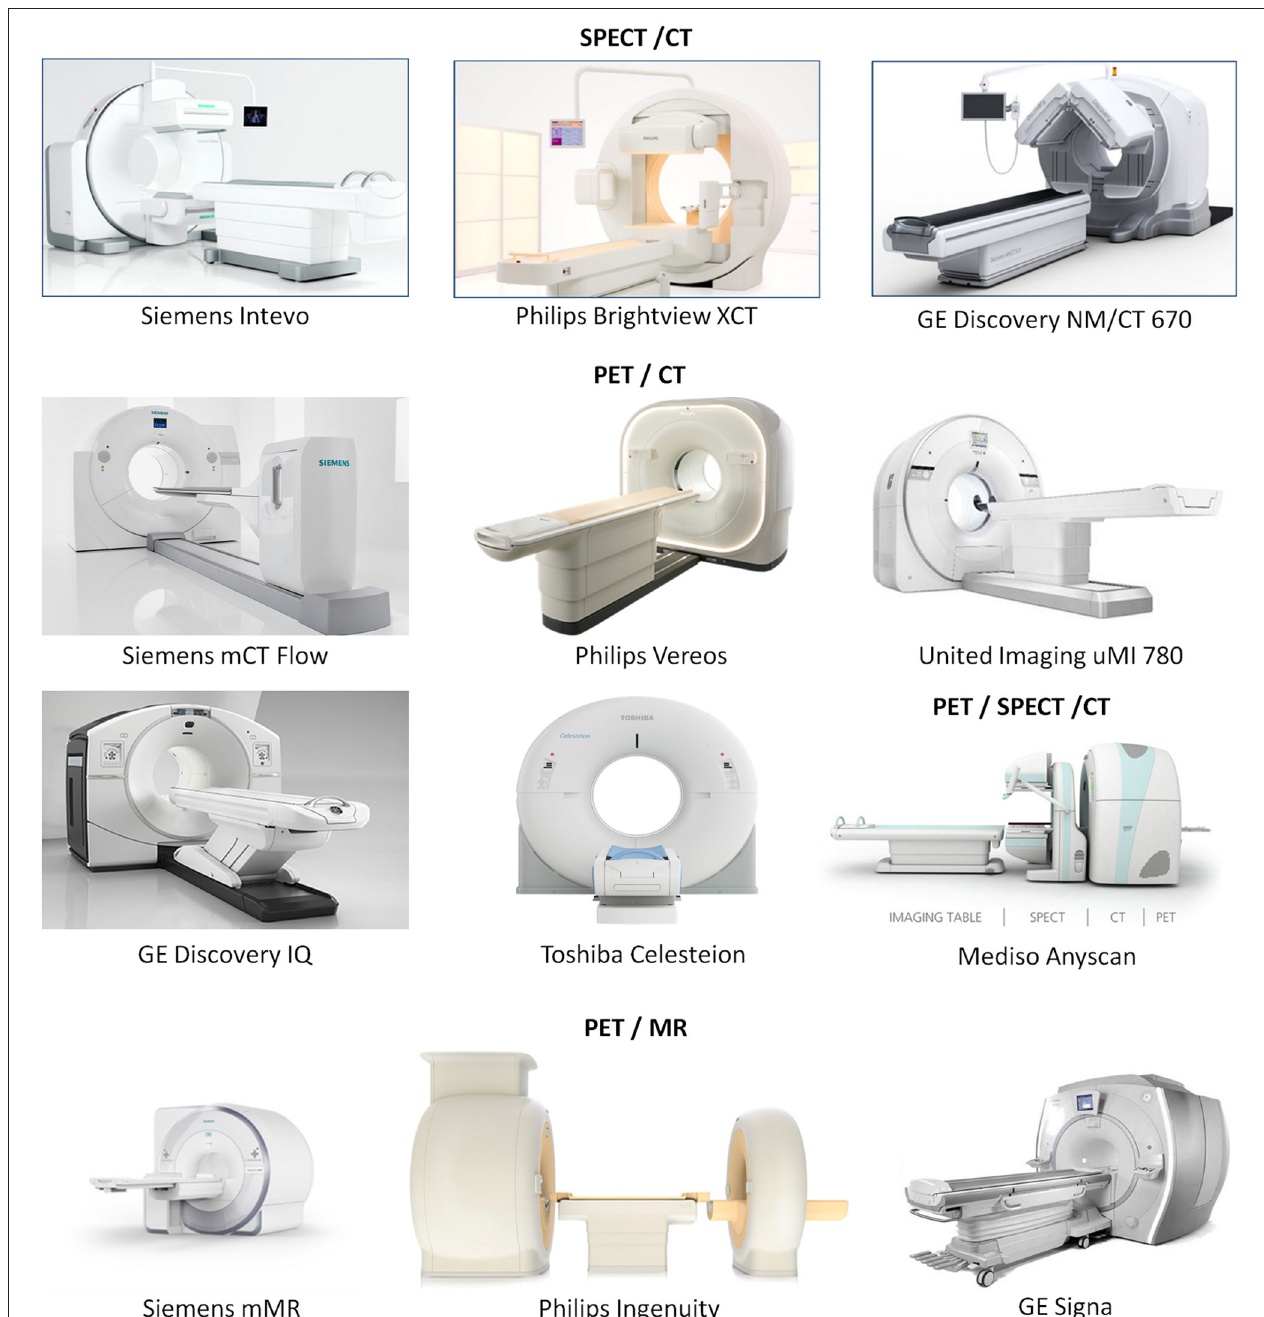
FIGURE 1 | Images of commercially available hybrid imaging systems for clinical use. The figure shows three SPECT/CT, five PET/CT, three PET/MR and one triple modality SPECT/PET/CT systems. Systems include the first CTM-PET(/CT) system (Siemens mCT Flow, see section Organ-Specific System Design and Total-Body Systems); two SiPM-based PET systems (GE Signa, uMI 780), the first digital SiPM based PET system (Philips Vereos); a BGO-based system (GE Discovery IQ) and the first commercially available fully-integrated PET/MR (Siemens mMR). Images taken from vendor’s web pages and published with the permission of the copyright holders (the respective